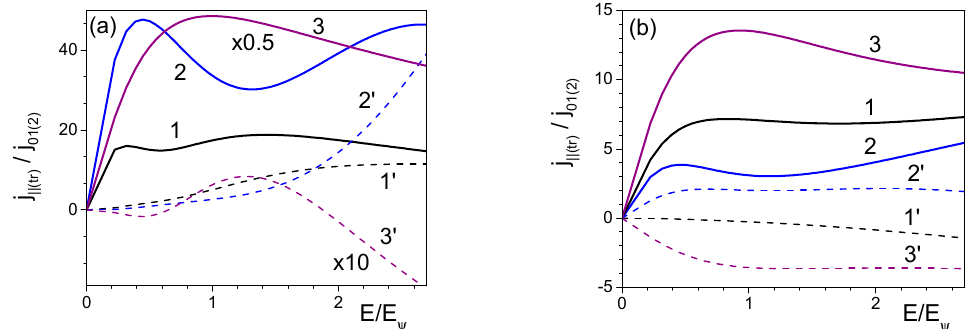
Figure 4. Dependences longitudinal j || (curves 1–3) and transversal j tr (curves 1 (cid:48) –3 (cid:48) ) current components on electric field E / E ψ in a direction angularly ( a ) ψ = π / 4.5 (1,1 (cid:48) ), π / 6.5 (2,2 (cid:48) ), π / 10 (3,3 (cid:48) ) to the field direction for parameter values are equal: ∆ 1 = ∆ 2 = 5 meV (curves 1,1 (cid:48) ), ∆ 1 = 2 meV, ∆ 2 = 10 meV (curves 2,2 (cid:48) ), ∆ 1 = 10 meV, ∆ 2 = 5 meV (curves 3,3 (cid:48) ), d 2 / d 1 = 2, k B T = 7 meV, ∆ 11 = ∆ 12 = 1; ( b ) ψ = π / 10, d 2 / d 1 = 2.7, ∆ 1 = ∆ 2 = 5 meV, k B T = 20 meV, ∆ 11 = 1, ∆ 12 = 1 (curves 1,1 (cid:48) ), ∆ 11 = 1, ∆ 12 = 10 (curves 2,2 (cid:48) ), ∆ 11 = 10, ∆ 12 = 1 (curves 3,3 (cid:48) ), δ 0 = 1.